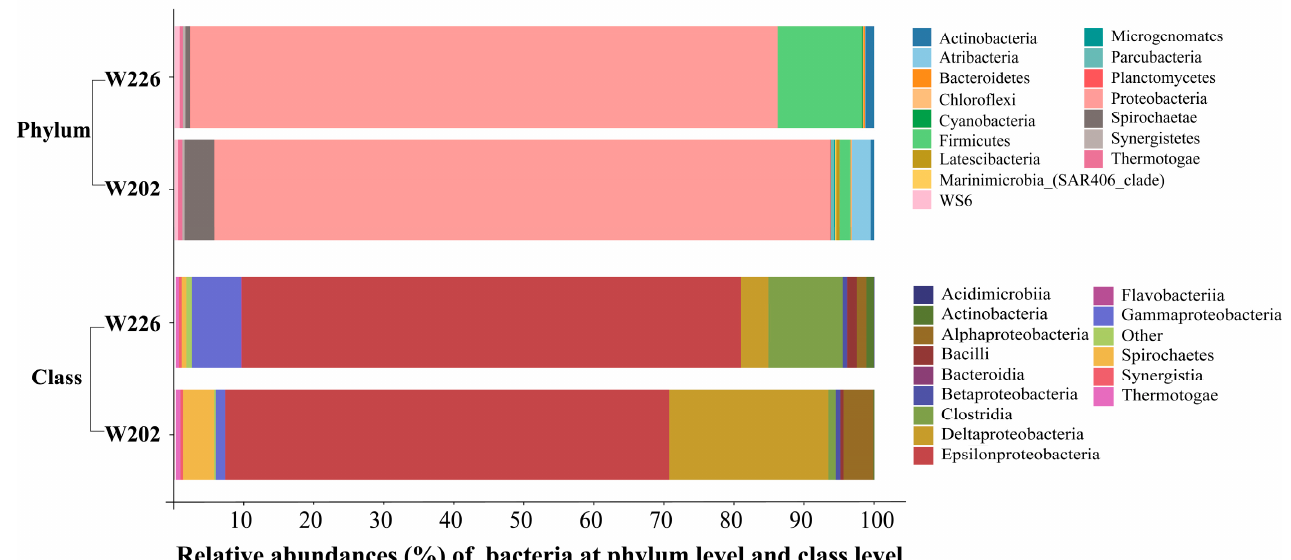
Figure 3. Community compositions of bacterial populations from the production and control well at the phylum and class level.